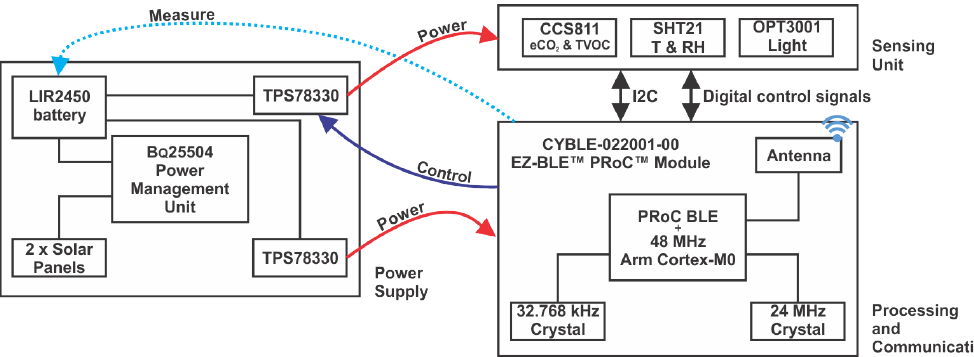
Figure 2. Air quality sensor block